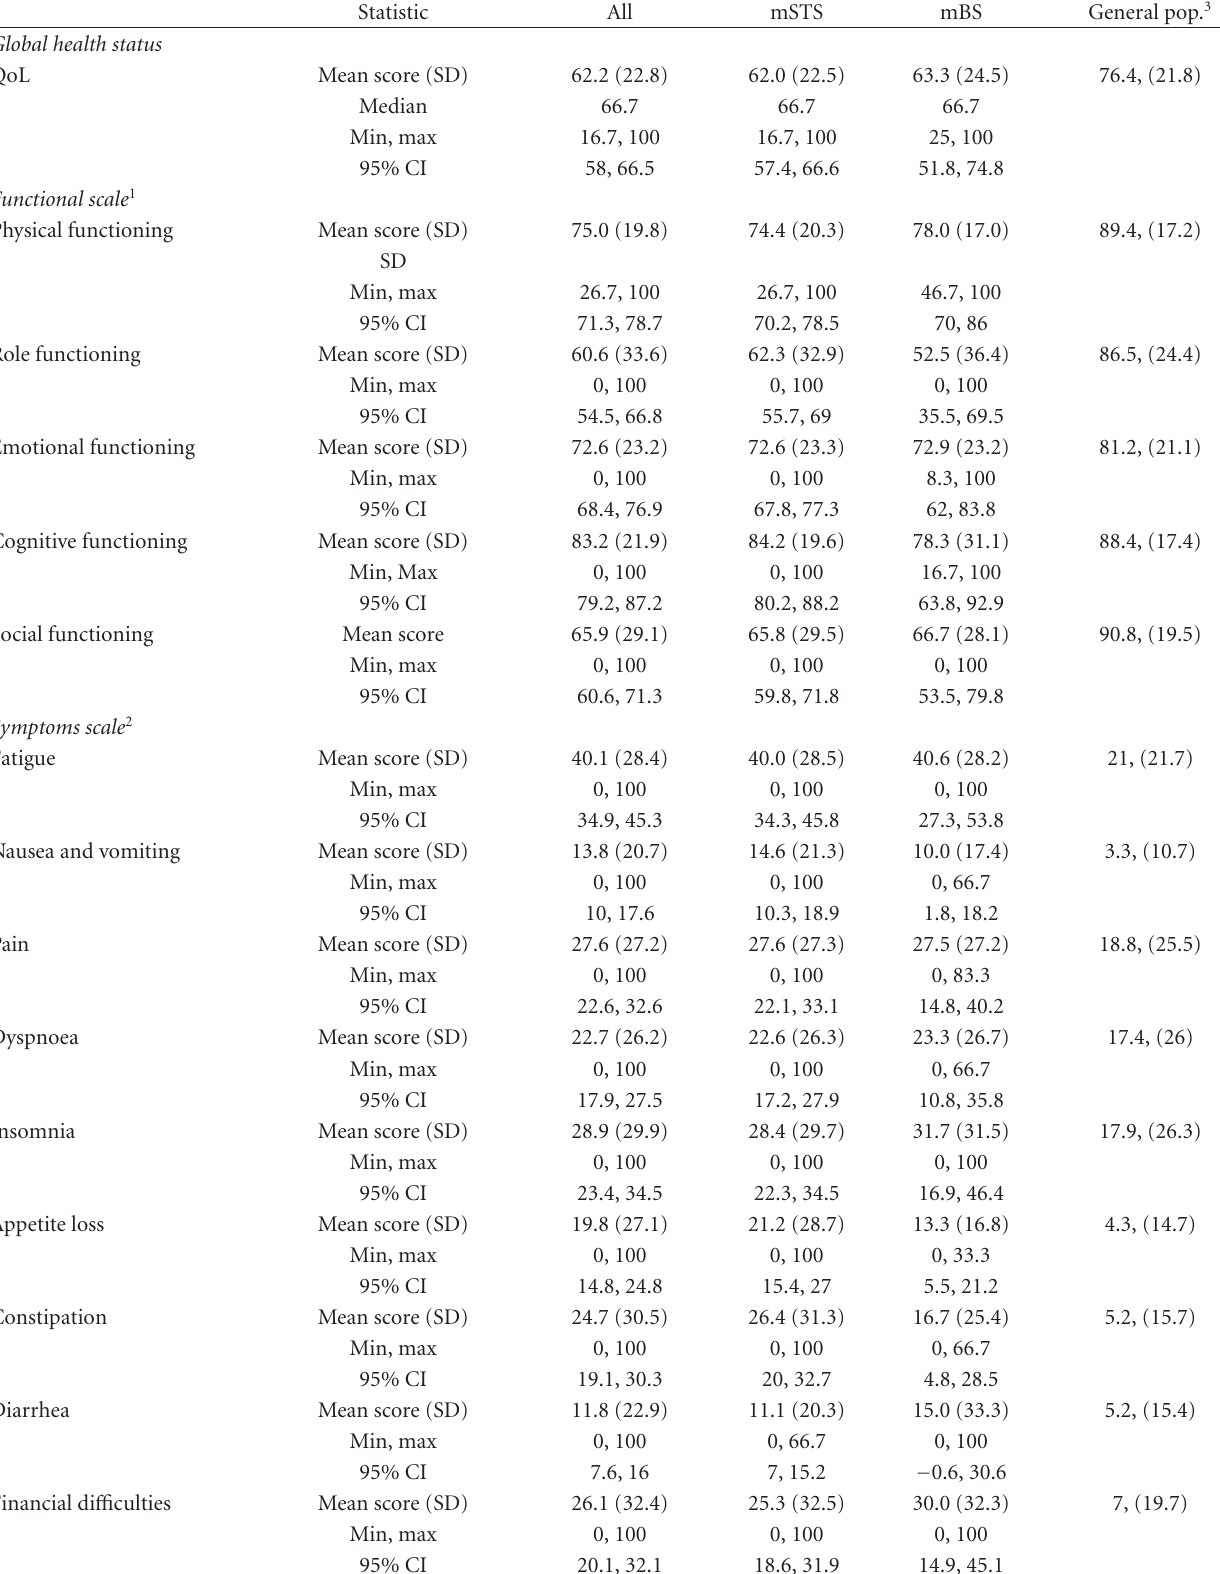
Table 5: Patients’ QoL based on the